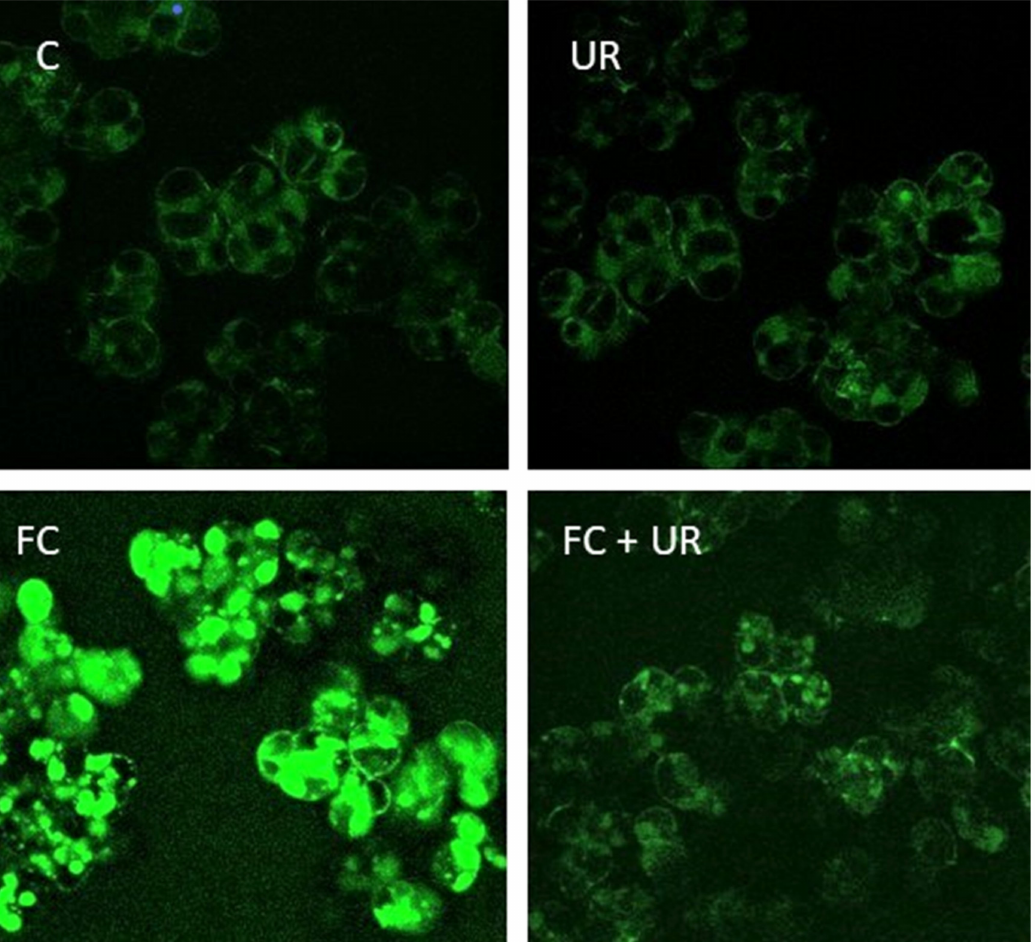
Figure 1. Effect of FC and urate on RNS accumulation in the cells. C, control cells; UR, cells treated with 1 mM urate; FC, cells treated with 20 µ M FC; FC + UR, cells treated with 20 µ M FC in the presence of 1 mM urate. Time of treatment 6